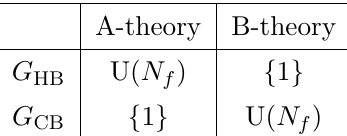
Table 3. Symmetry group of the Higgs Branch ( G HB ) and of the Coulomb Branch ( G CB ) for A-theory and